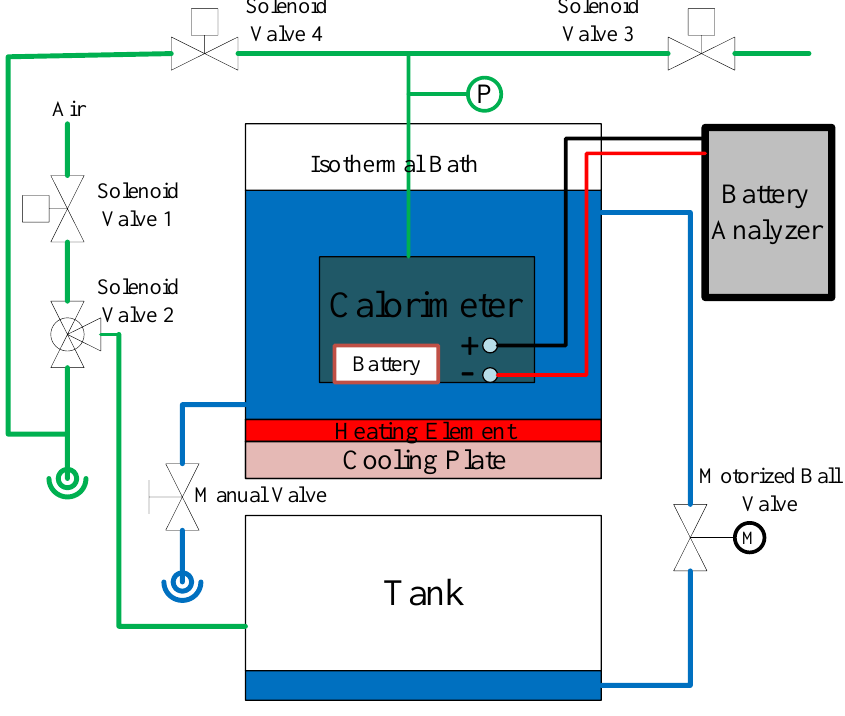
Figure 1. Main diagram of the IBC 284.